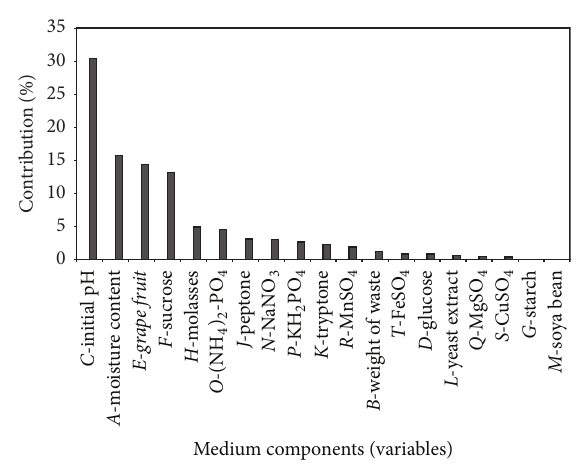
Figure 1: Pareto chart representing the percentage contribution of the nutrient